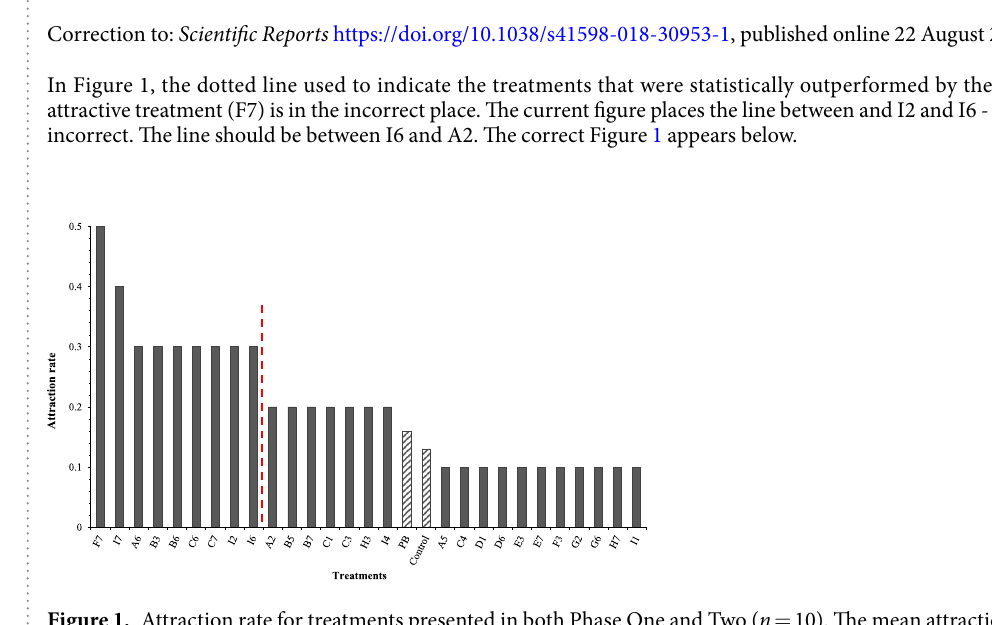
Figure 1. Attraction rate for treatments presented in both Phase One and Two ( n = 10). The mean attraction rate for the control and peanut butter standard (PB) were 0.13 and 0.16, respectively, and are shown hatched to provide differentiation from treatments. Treatments to the left of the dotted line statistically outperformed the peanut butter standard and the control ( P <